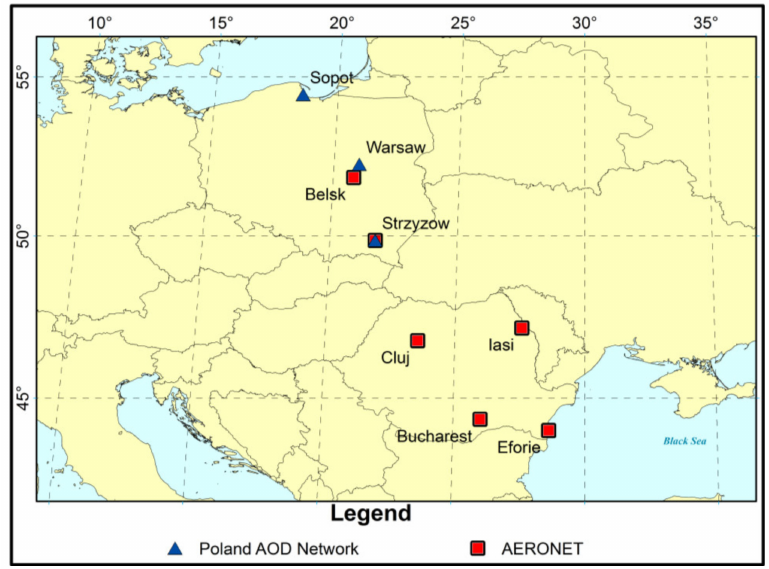
Figure 1. Ground stations used in the SEVIRI NRT AOD validation in the framework of SAMIRA. Within the AERONET network, the measurements were made with the Cimel Elec- tronique 318A sun photometers (675 nm) at four stations in Romania: Cluj, Iasi, Eforie and Bucharest and two in Poland: Belsk and Strzyzow. We used AERONET version 3 and AOD level 2 data, which was automatically cloud-cleared and manually inspected, with pre- and post-field calibration applied. Within the Poland–AOD Network, the measurements were made with the Multifilter Rotating Shadowband Radiometers MFR-7 radiometers (613 and 674 nm) at three stations: Warsaw, Sopot and